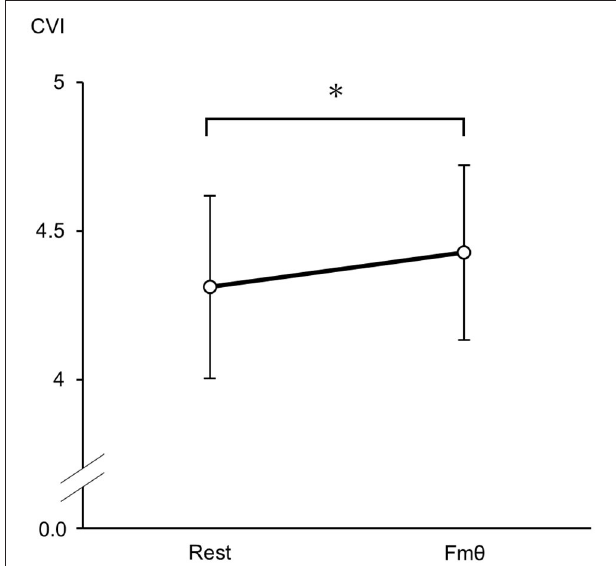
FIGURE 2 | Cardiac sympathetic index (CSI) changes during the rest condition and Fm θ condition. Values are expressed as means and SDs. * p < 0.05.